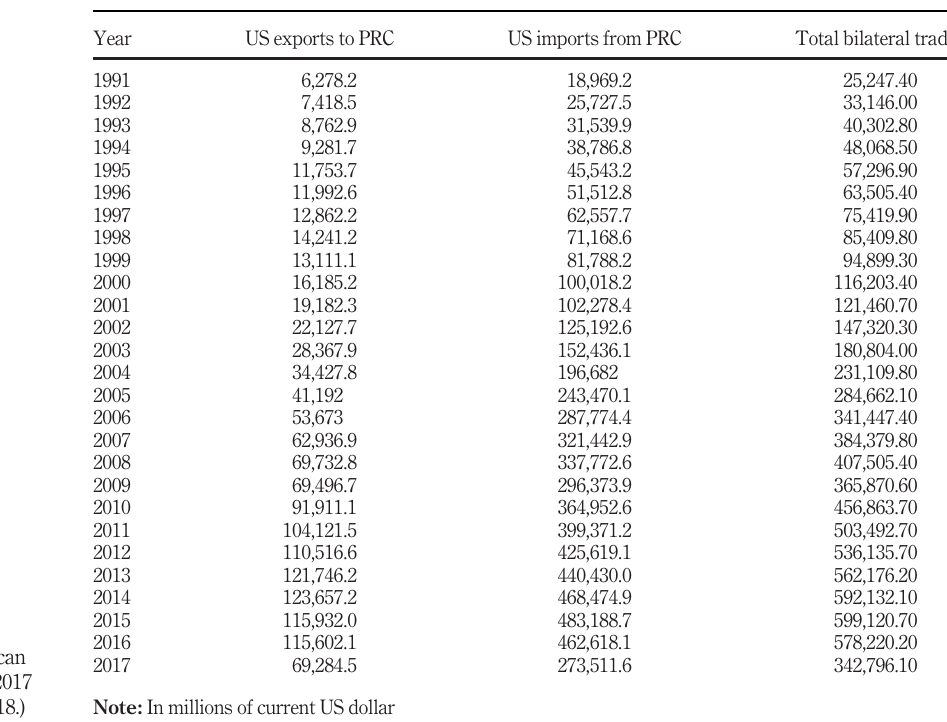
Table II. Sino – American trade, 1991-2017